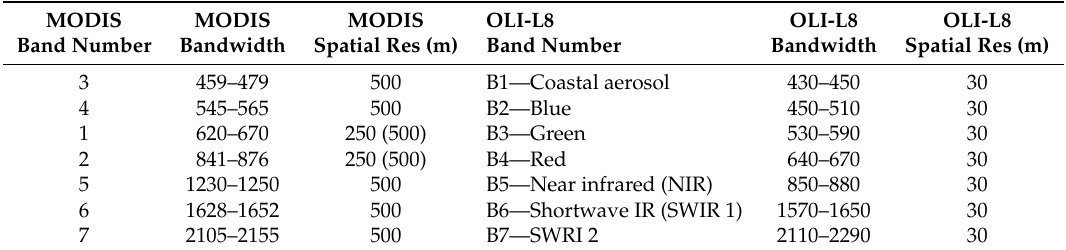
Table 1. Spectral and spatial characteristics of MODIS and OLI sensors. The MODIS Bands 1 and 2 have a resolution of 250 m, while the MCD43A1 has a resolution of 500